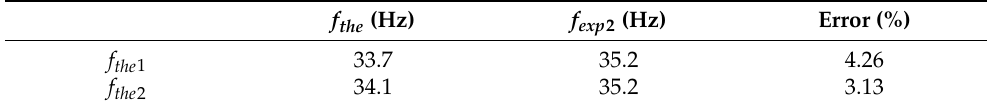
Figure 10. Frequency response of the system during the uniform speed process. Table 4. Theoretical and experimental results of system frequency during the uniform speed process.